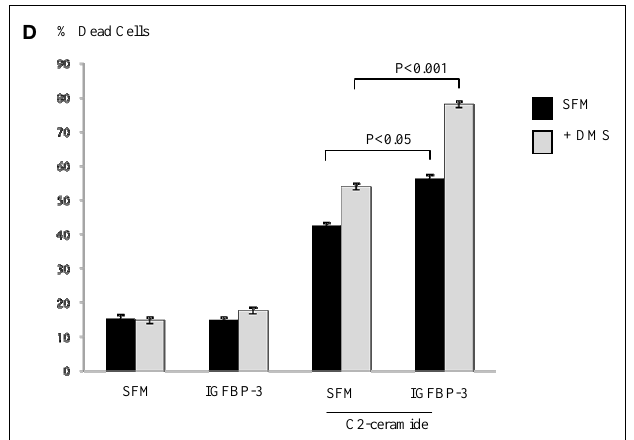
FIGURE 6 | Hs578T cells were seeded in six-well plates at 0.1 × 10 6 cells in GM followed by 24h in SFM. Cells were pre-dosed for 24h with IGFBP-3 (100ng/ml) prior to redosing ± an apoptotic dose of antimycin A (A). Graph represents cell surface ceramide as assessed by flow cytometry and is the mean ± SEM of three experiments. Cells were pre-dosed with IGFBP-3 for 24h ± a ceramide blocking antibody (1 μ g/ml) prior to redosing ± an apoptotic dose of antimycin A (B). Graph represents changes in cell death and shows the mean ± SEM of three experiments each repeated in triplicate. (C) Shows phase contrast photomicrographs (magnification × 100) of Hs578T cells following treatment described in (B) , which are representative of experiments repeated three times. Cells were pre-dosed for 24h with IGFBP-3 (100ng/ml) ± DMS (0.5 μ M) and then re-dosed ± an apoptotic dose of C2-ceramide (D). The graph represents changes in cell death and shows the mean ± SEM of three experiments each repeated in